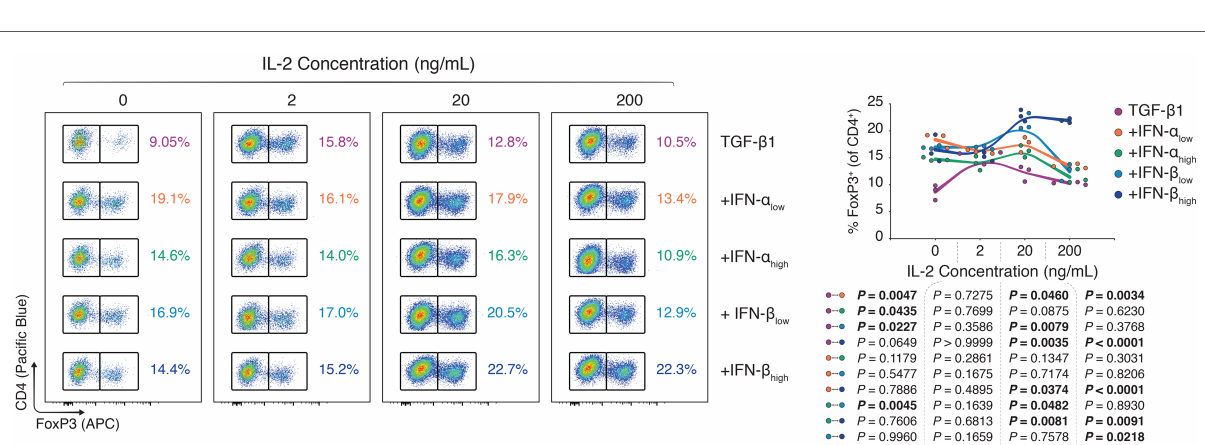
FIGURE 4 Type I interferons augment FoxP3 T reg polarization in concert with ancillary cytokine signals . Murine splenocytes were harvested and expanded for three days with anti-CD3 (1 μ g/ml), anti-CD28 (1 μ g/ml), and TGF- β 1 (10 ng/ml; TGF- β 1). In separate wells, IFN- α low (1,000 IU/ml; +IFN- α low ), IFN- α high (10,000 IU/ml; IFN- α high ), IFN- β low (1,000 IU/ml; +IFN- β low ), or IFN- β high (10,000 IU/ml; IFN- β high ) were added to the TGF- β 1 condition. For all three conditions, the IL-2 concentration was titrated (0 – 200 ng/ml; n =3 technical replicates/condition; 1 of 2 experiments). Flow cytometric analysis and XY plots of FoxP3 + T regs among CD4 + T cells under varying concentrations of interleukin 2. Data represent all individual data points of the denoted experimental groups. P values were calculated with mixed-effects model analyses using the Geisser-Greenhouse correction followed by Tukey multiple comparison tests. IFN- α , interferon alpha; IFN- β , interferon beta; IL-2, interleukin 2; MFI, mean fl uorescence intensity; TGF- β 1, transforming growth factor beta